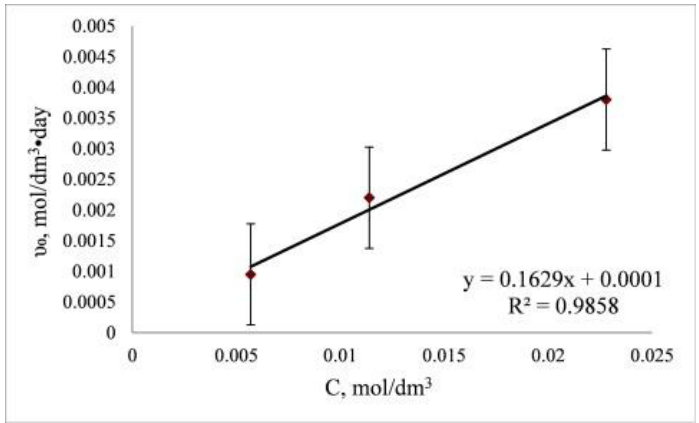
Figure 4. Linear dependence of the initial rate of the biodegradation process of CAPB by the strain Pseudomonas pseudoalcaligenes (B-6783) VSB-10 on the initial surfactant concentration.